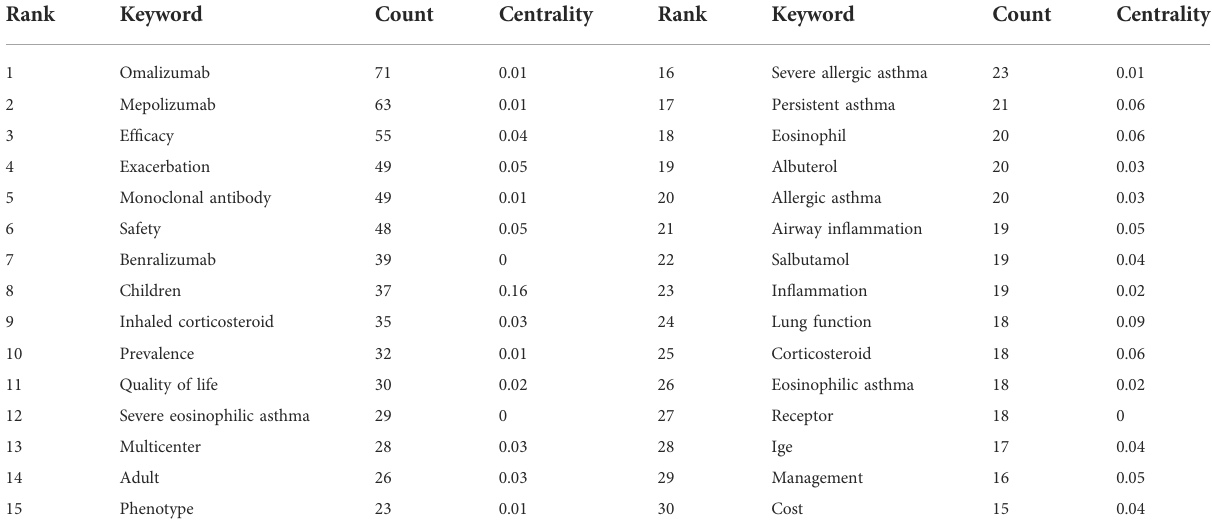
TABLE 4 Top 30 keywords with the highest count in severe asthma drug-related studies.